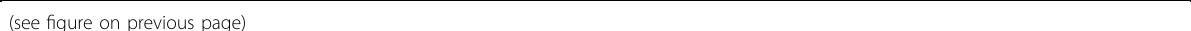
Fig. 2 Neuronal subtype characterizations of CiNs in the striatum and the cortex. a Schematic diagram of chemical reprogramming in the striatum or the cortex of the Aldh1l1-cre mice injected with AAV-FLEX-EGFP and AAV-vGAT-mCherry or AAV-vGLUT2-mCherry sequentially. IF, immuno fl uorescence. b Conversion ef fi ciency showing the generation of the VGAT-mCherry + /NEUN + /EGFP + cells induced in the striatum and the VGLUT2-mCherry + /NEUN + /EGFP + cells induced in the cortex ( n = 3 mice). c Striatal neuronal subtype markers, including VGAT-mCherry, DARPP32, PVALB, and NPY were detected in CiNs generated in the striatum of adult mice. Arrowheads show the co-localization of EGFP and the corresponding markers. d Cortical neuronal subtype markers, including VGLUT2-mcherry, CTIP2, TBR1, and PVALB were detected in CiNs generated in the cortex of adult mice. Arrowheads indicate the co-localization of EGFP and the corresponding markers. Scale bars, 25 μ m. Error bars represent